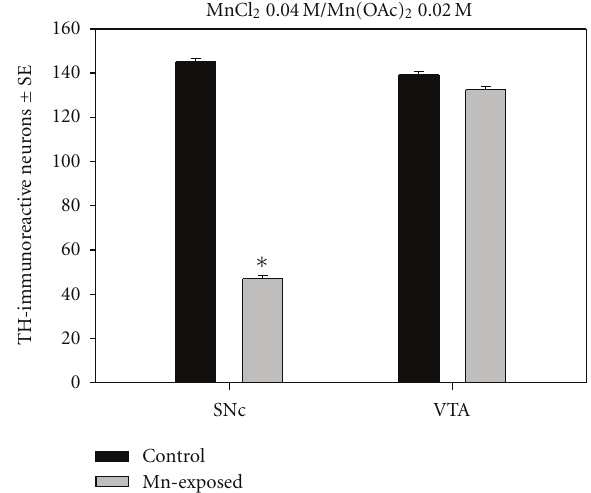
Figure 8: TH-immunoreactive cell counts from the Substantia Nigra compacta (SNc) and Ventral Tegmental Area (VTA). The data are presented as the mean ± SE. A statistically significant decrease in TH-immunoreactive cells was detected in the SNc ( ∗ P < . 05 ANOVA test) of Mn-exposed mice compared to controls with no di ff erence in the